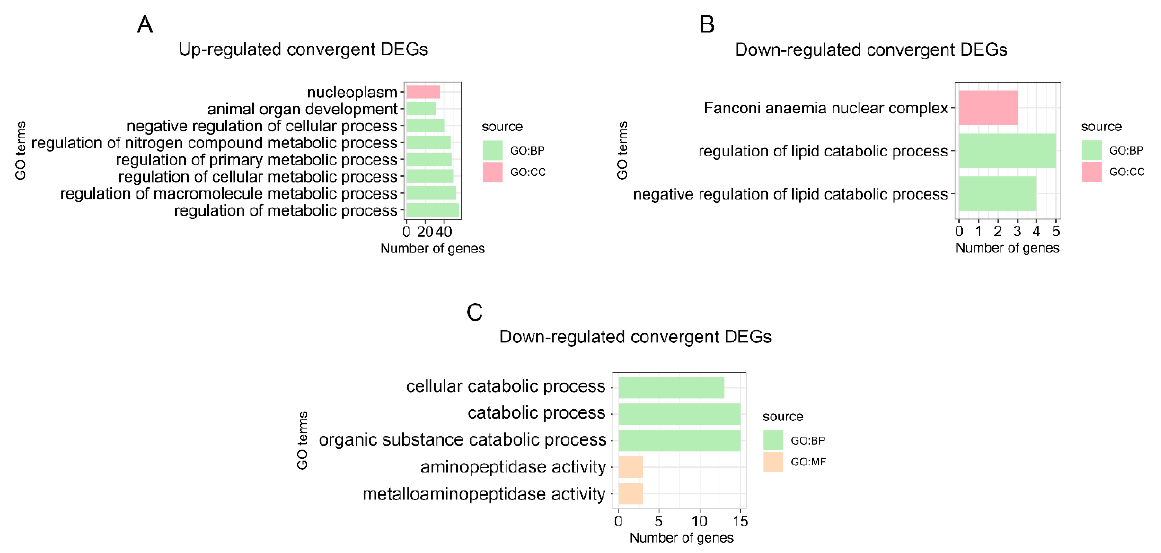
Figure 3. Significantly enriched GO categories for convergent DEGs. Up-regulated ( A ) and down- regulated ( B ) convergent DEGs of the two pandas in the stomach. Down-regulated ( C ) convergent DEGs of the two pandas in the small intestine. BP represents biological process, CC represents cellular component, and MF represents molecular function.